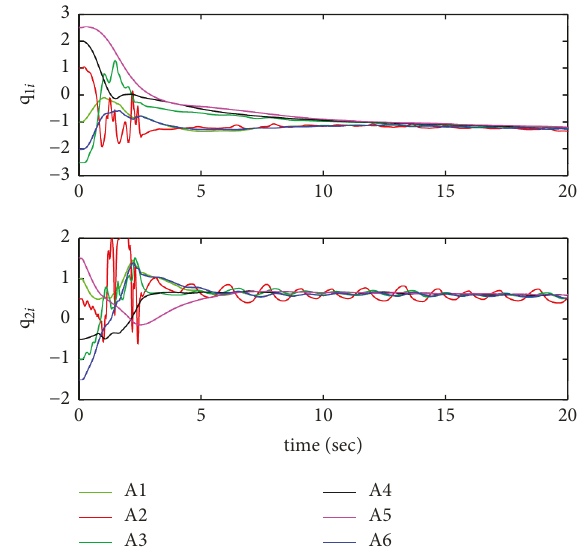
Figure 11: The states q